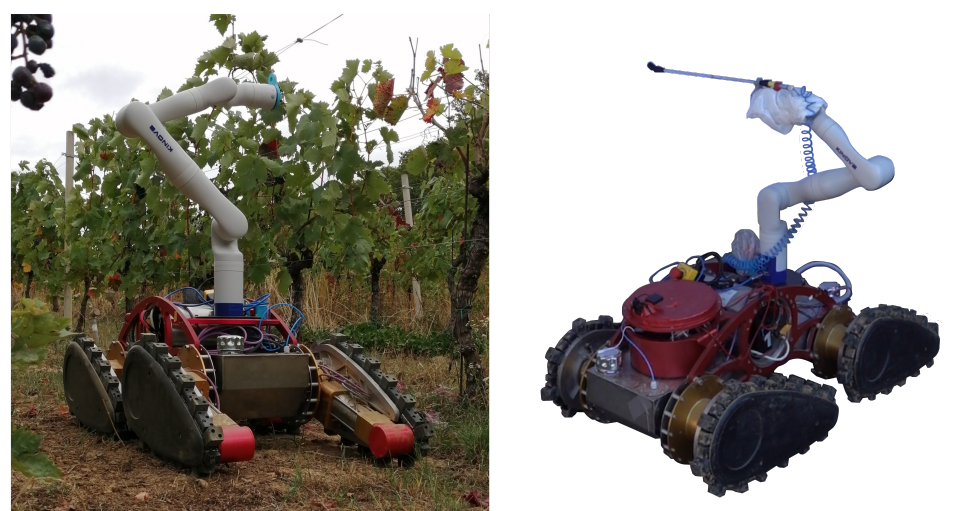
Figure 1. Mobile manipulator developed for the HEKTOR project, with an emphasis on manipulation ability and maneuverability in steep